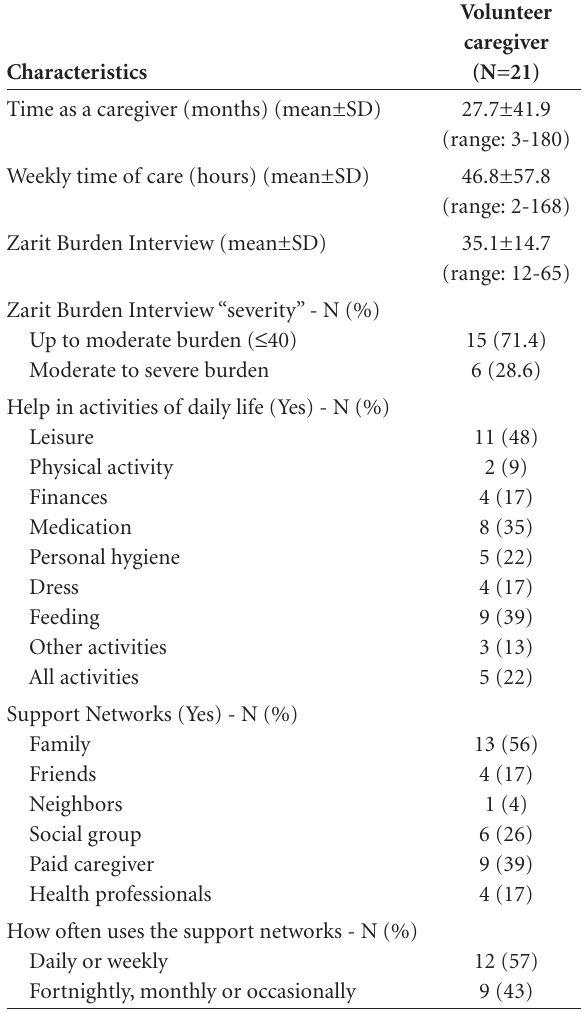
Table 2. Characteristics of volunteer